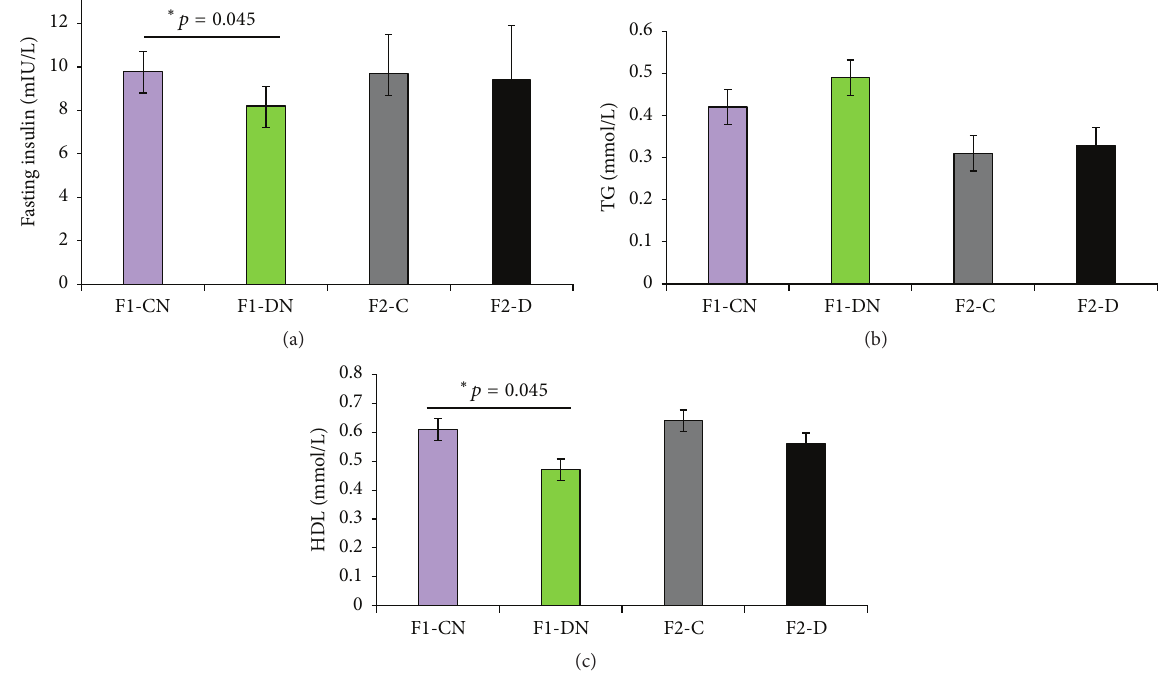
Figure 4: Biochemical analysis of F1 and F2 offspring at 28 weeks. (a) Level of fasting insulin in F1 and F2 offspring. (b) TG level in F1 and F2 offspring. (c) HDL level in F1 and F2 offspring. Results are presented as means ± SEM, 𝑁 = 6 per group; ∗ 𝑝 < 0.05 versus